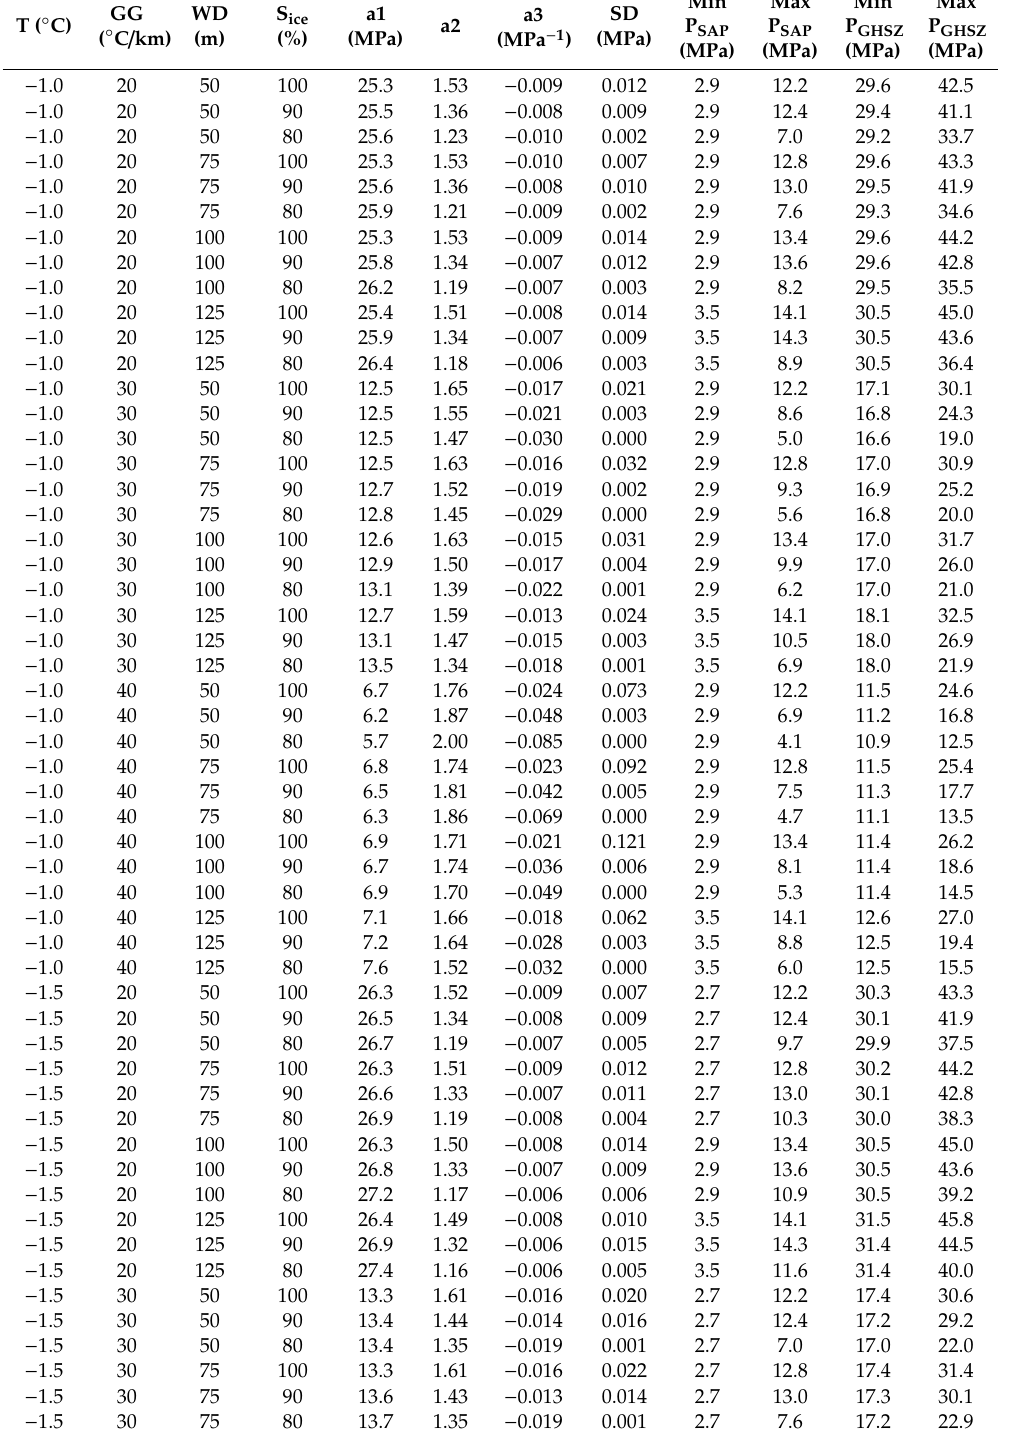
Table 2. Fitting parameters a1, a2, and a3 for modeled bottom water temperatures (T), geothermal gradient (GG), and water depths (WD) for the pore water with a 3.5 wt.% salinity (brine). The standard deviation (SD) is also reported, as well as the range of pressure in which the hydrate stability is satisfied, indicated as Min / Max P SAP and Min / Max P GHSZ